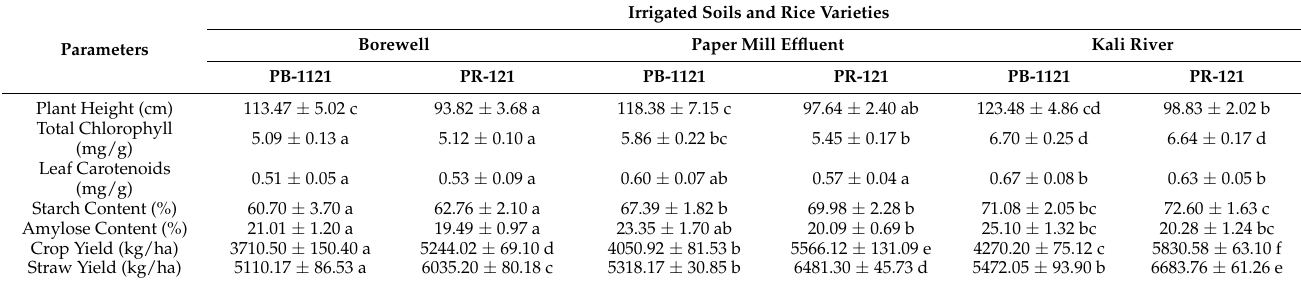
Table 3. Impact of different irrigation water sources on growth and productivity performance of two rice